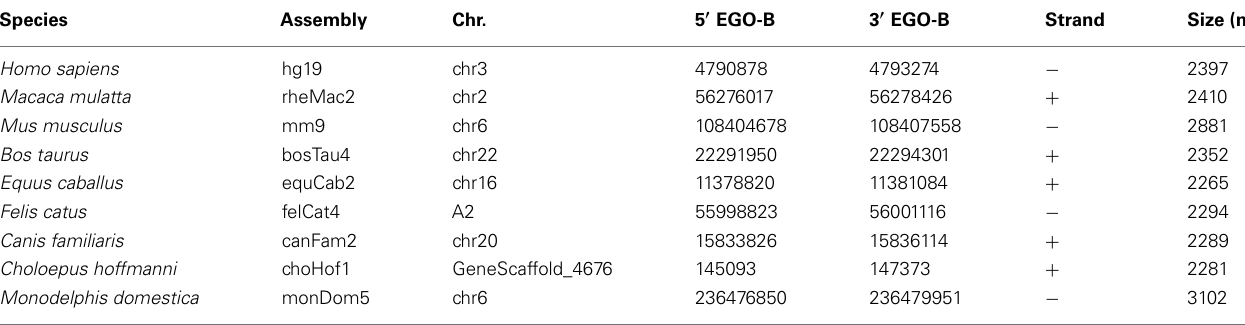
Table 1 |Approximate genomic locations of EGO-B